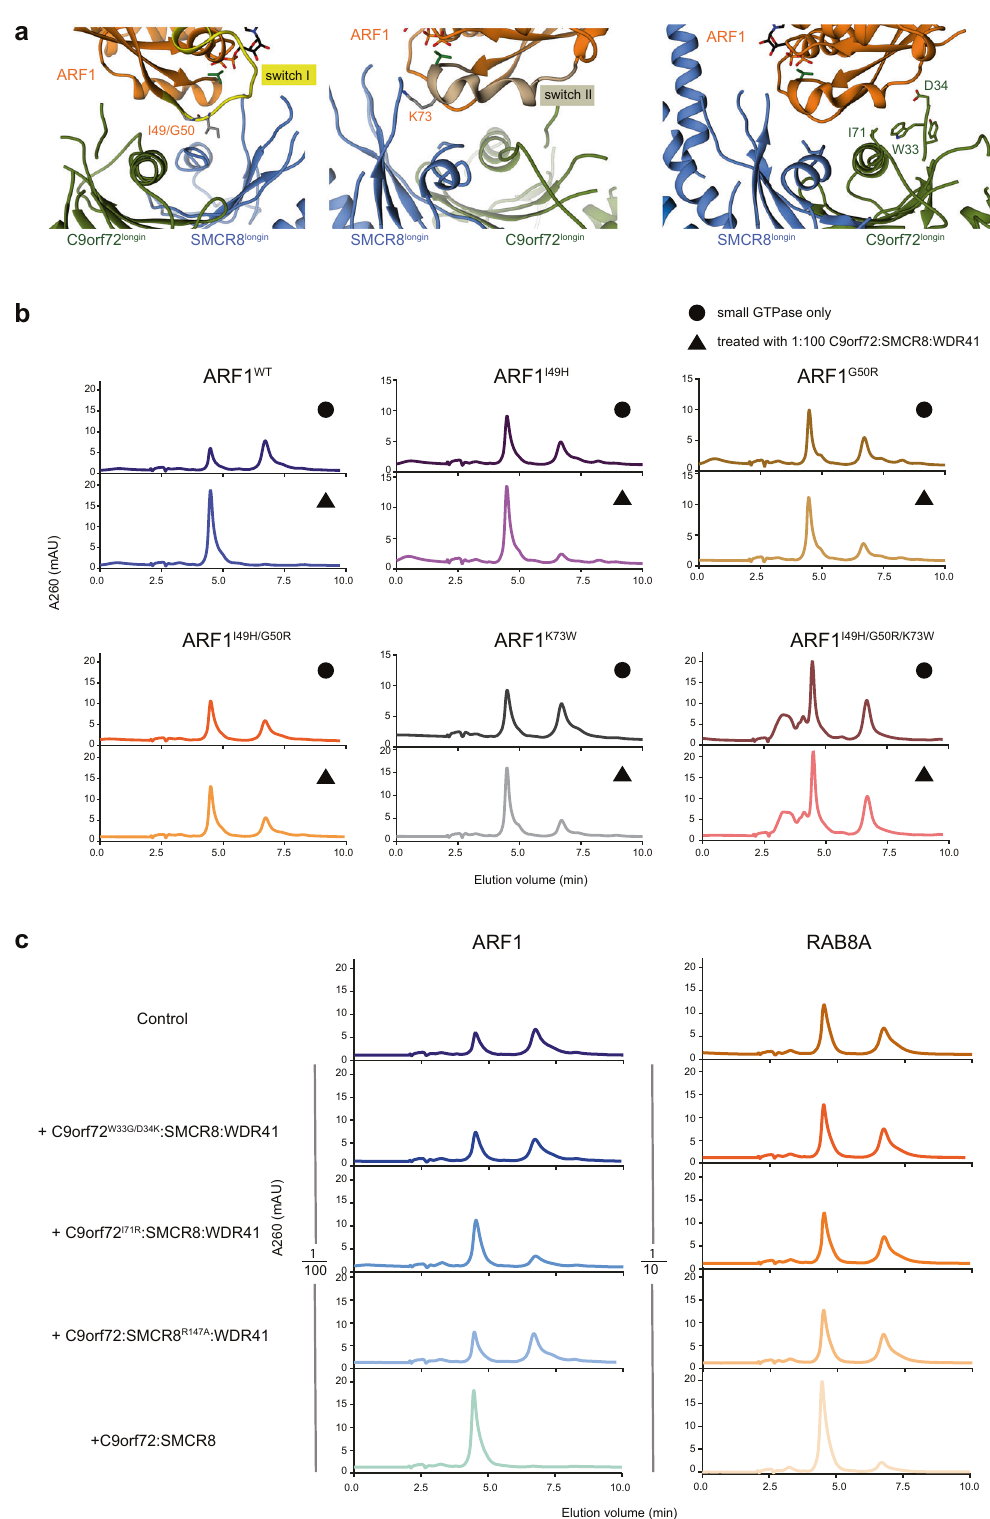
Fig. 4 Interfaces between ARF1 and C9orf72/SMCR8 and HPLC result of ARF1 WT/mutants with C9orf72 WT/mutants :SMCR8:WDR41. a Close-up views of the interfaces between switch I/switch II regions of ARF1 with C9orf72:SMCR8. b HPLC analysis of ARF1 WT/mutants incubated with C9orf72:SMCR8: WDR41. The top panels are the control reactions for each ARF1 proteins, either wild-type or mutants. The bottom ones are incubated with 1/100 molar ratio of C9orf72:SMCR8:WDR41. c ARF1 or RAB8A incubated with 1/100 or 1/10 molar ratio of C9orf72 WT/mutants :SMCR8:WDR41, respectively. The experiments in b , c are carried out at least three times, and one representative plot is